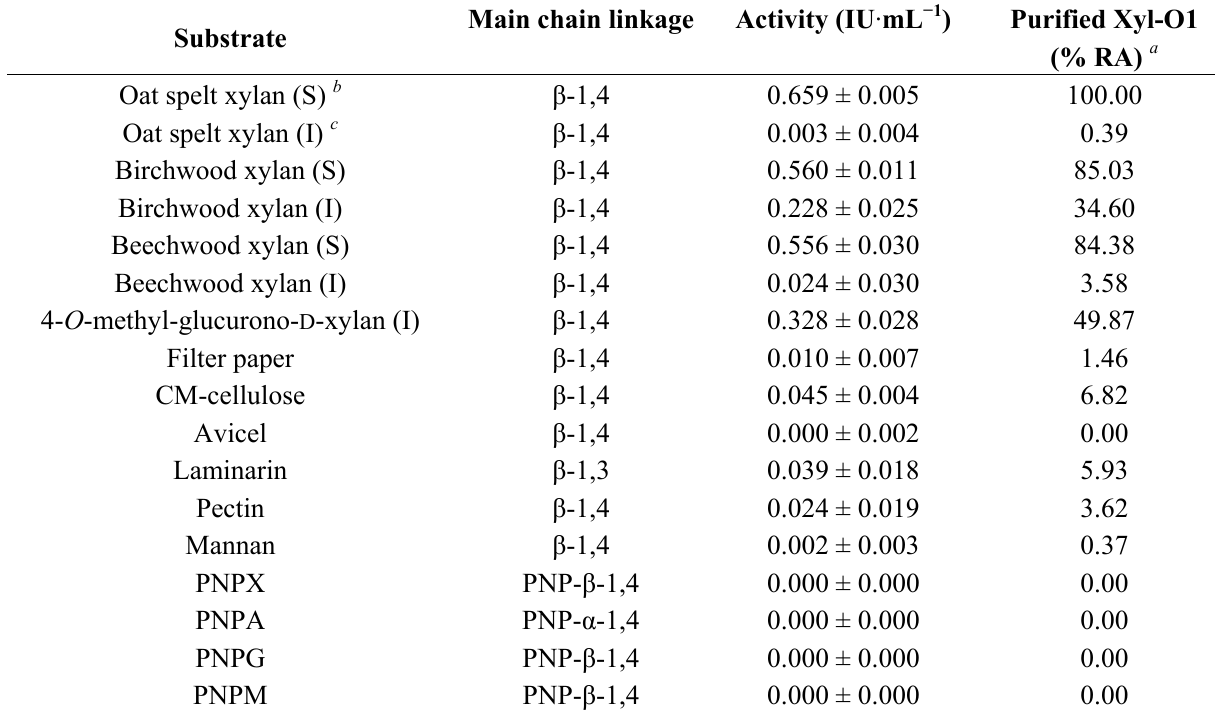
Table 4. Substrate specificity of purified Aspergillus oryzae